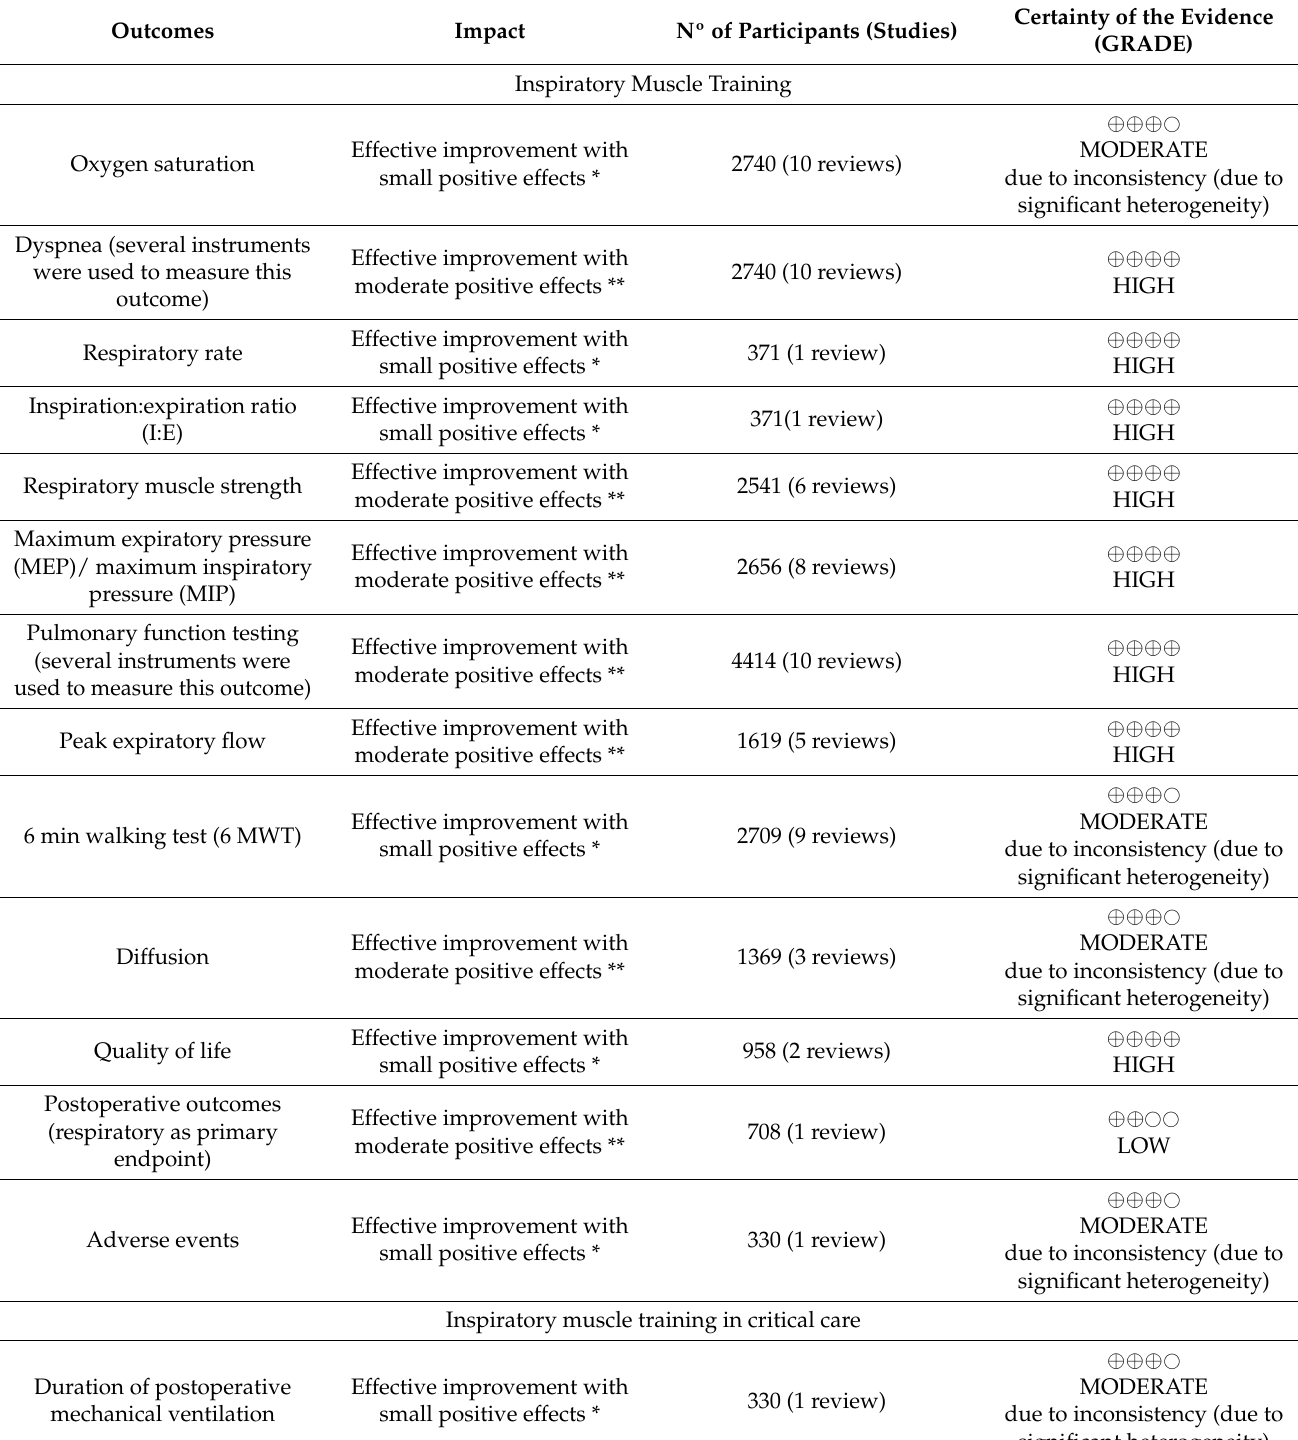
Table 5. Summary of